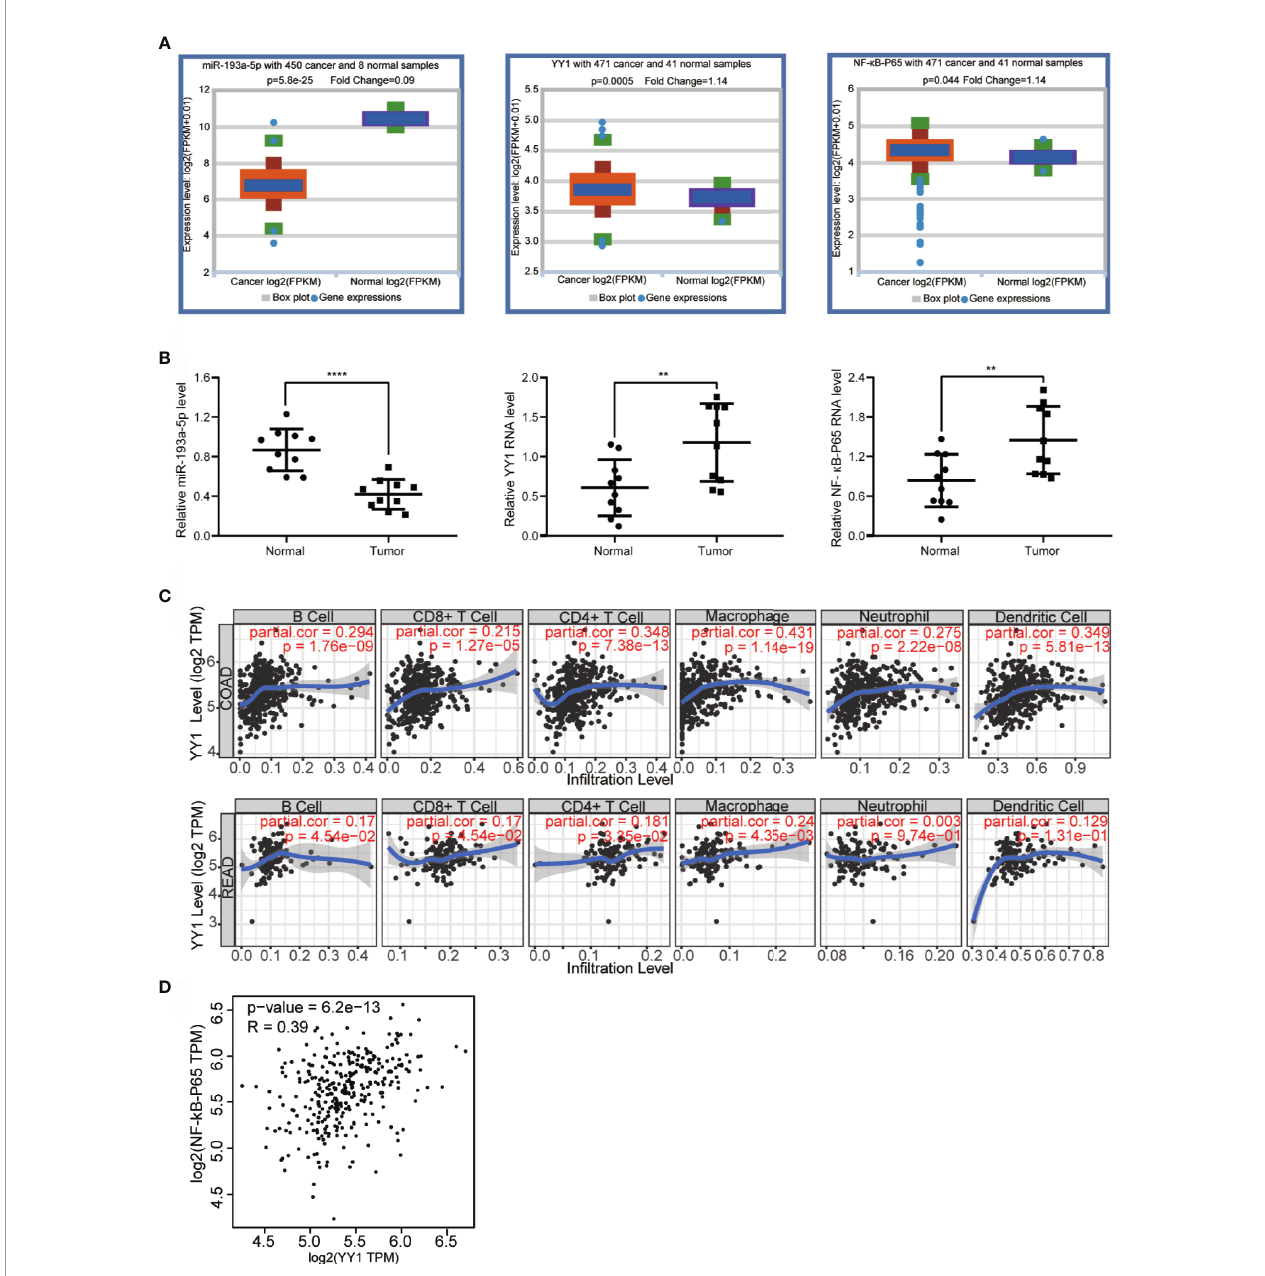
FIGURE 7 | Bioinformatics analysis and clinical sample veri fi cation. (A) Starbase demonstrated that miR-193a-5p is dramatically downregulated in CRC, while YY1 and NF- к B-p65 were upregulated in CRC compared with normal colorectal tissues. (B) The expression levels of miR-193a-5p, YY1 and NF- к B-p65 in CRC tissues were veri fi ed in 10 paired samples by qRT-PCR. (C) The effect of YY1 on the immune cell in fi ltration of CRC was investigated by TIMER (COAD stands for colon cancer, READ stands for rectal cancer). (D) The correlation between YY1 and NF- к B-p65 was explored by GEPIA. (P<=0.05 means statistically signi fi cant, **p < 0.01, ****p <